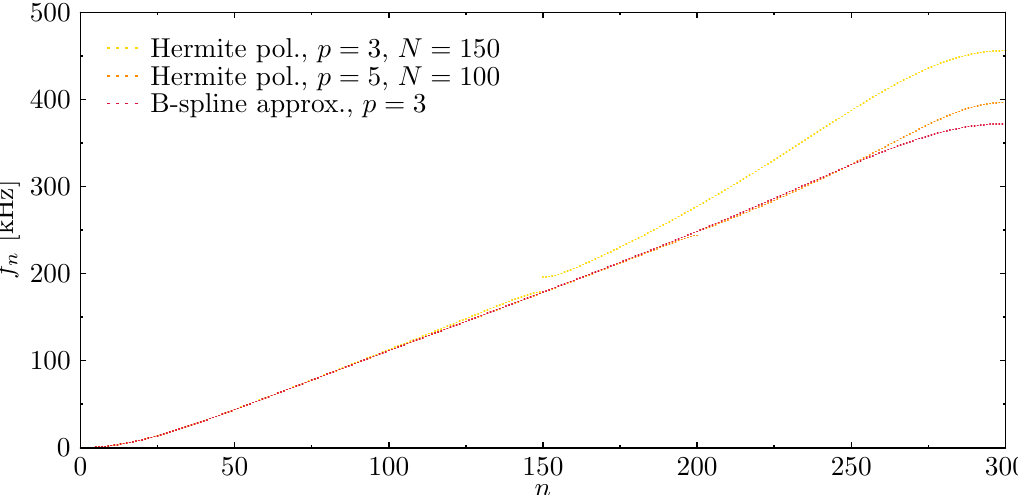
Figure 10. Natural frequencies of the beam calculated based on different approximation polynomials, in the case of a beam with simply-supported